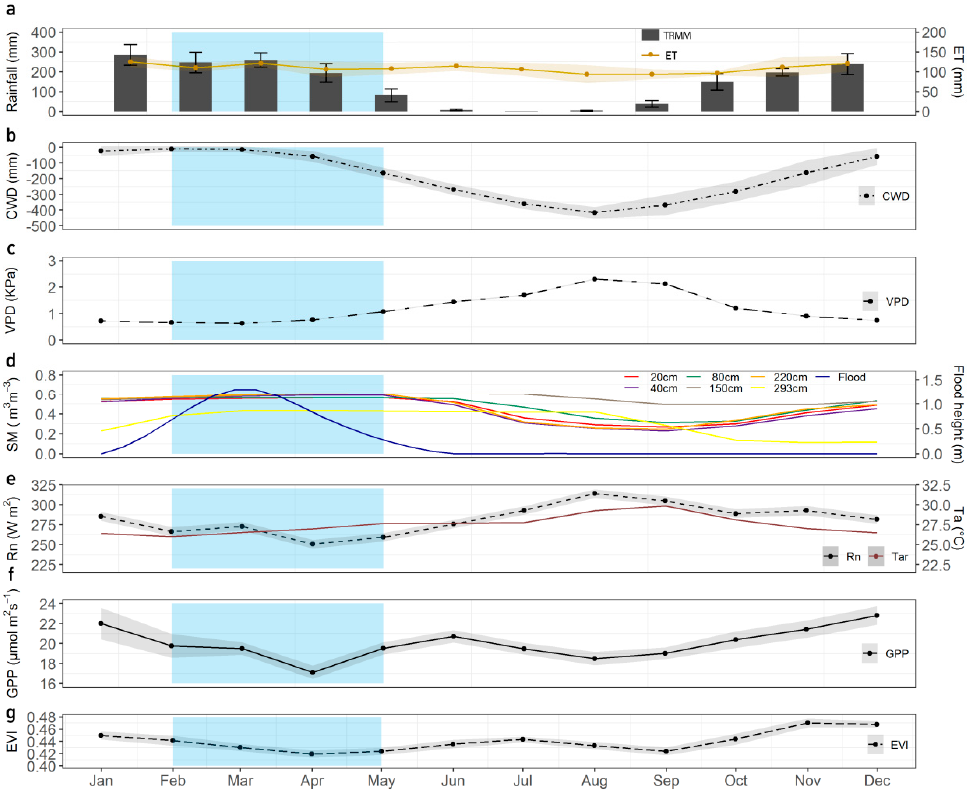
Figure 2. Average annual cycle of ET (2004 to 2014; black line) and rainfall from TRMM (2004 to 2016; dark grey bar) ( a ), cumulative water deficit (2004 to 2016; CWD) ( b ), vapour pressure deficit (2004 to 2014; VPD) ( c ), soil moisture (2004 to 2016; SM) and flood height (2004 to 2016; dark blue line) ( d ), net radiation (2004 to 2016; dashed black line) and air temperature (2004 to 2014; brown solid line) ( e ), GPP (2011 to 2013; black solid line) ( f ), and EVI (2004 to 2016; long dashed black line) ( g ). The shaded blue area corresponds to the flooded period.